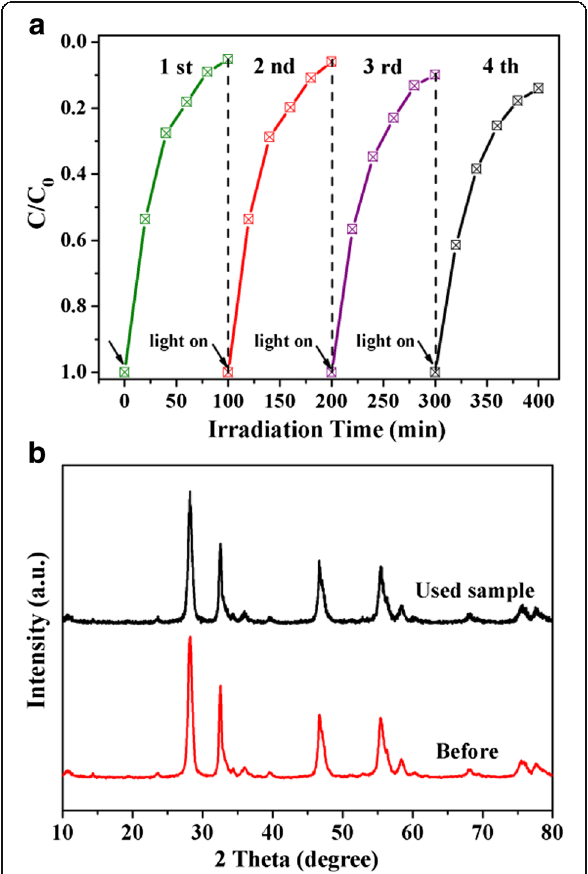
Fig. 8 a Cycling runs for degradation of RhB over the WS 2 /Bi 2 MoO 6 composite (5 wt%) under visible-light irradiation. b XRD patterns of the the WS 2 /Bi 2 MoO 6 sample before and after four-cycle